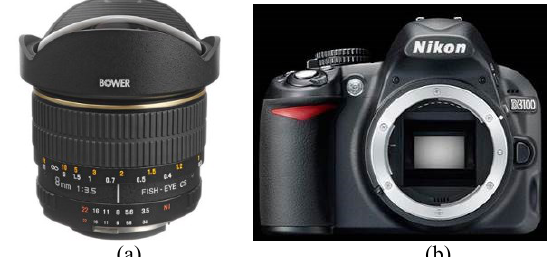
Figure 2 – (a) The Samyang-Bower 8mm fisheye lens camera and; (b) the Nikon D3100 digital camera.